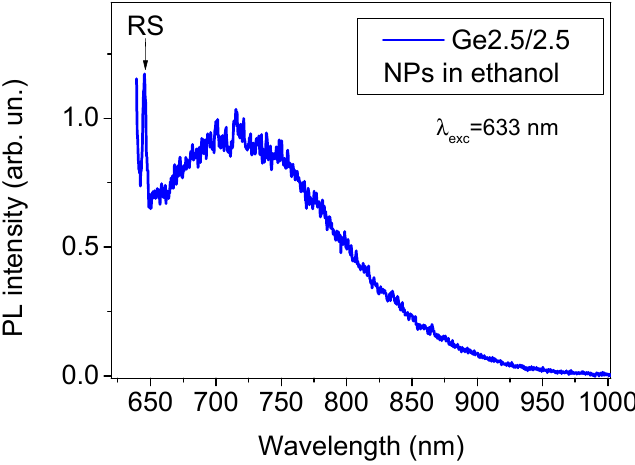
Figure 5. Photoluminescence spectrum from small size fraction of Ge NPs from Ge2.5/2.5 sample under 633 nm laser excitation. RS signature shows the position of Raman scattering peak at 298–299 cm − 1 associated with Ge nanocrystals.